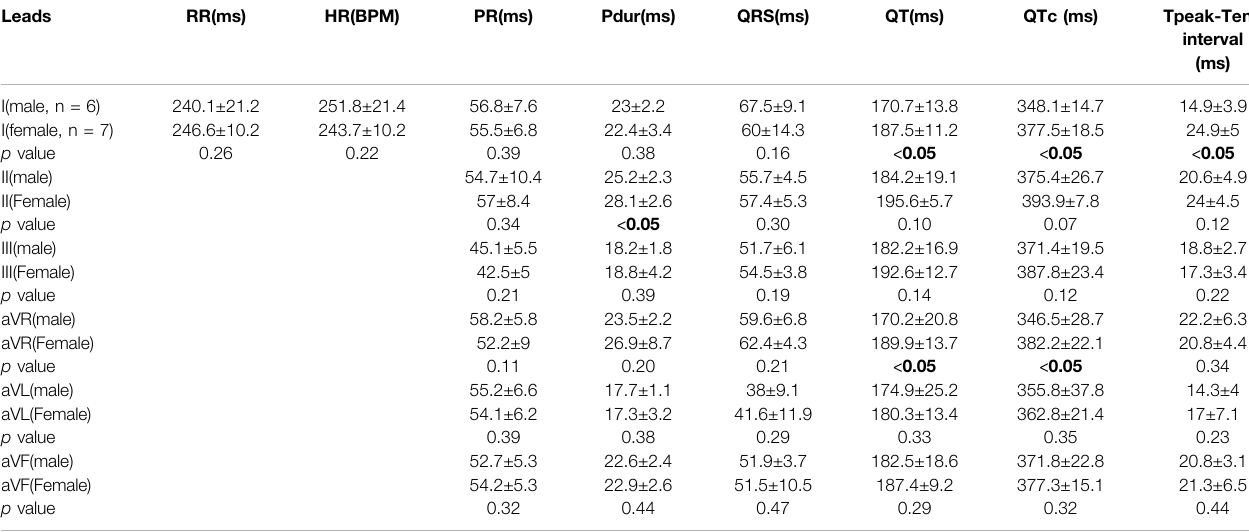
TABLE 8 | Sex-dependent effects on ECG parameters using six frontal plane leads in older adult guinea pigs (NES-AN). Lead RR(ms)